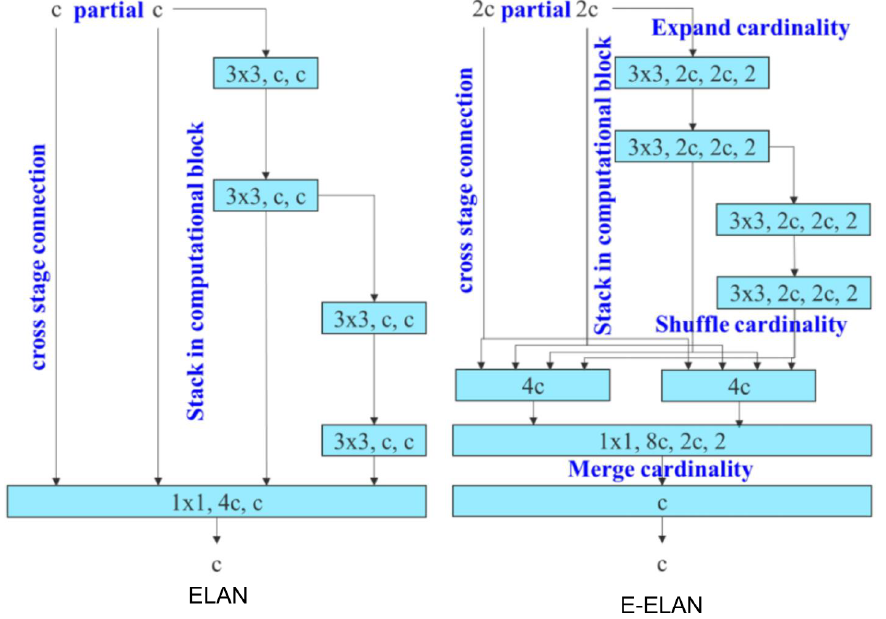
Figure 12. The architecture of ELAN and E-ELAN for efficient learning and faster convergence [9]. Second is the proposed Model Scaling for Concatenation-based Models (MSCM).